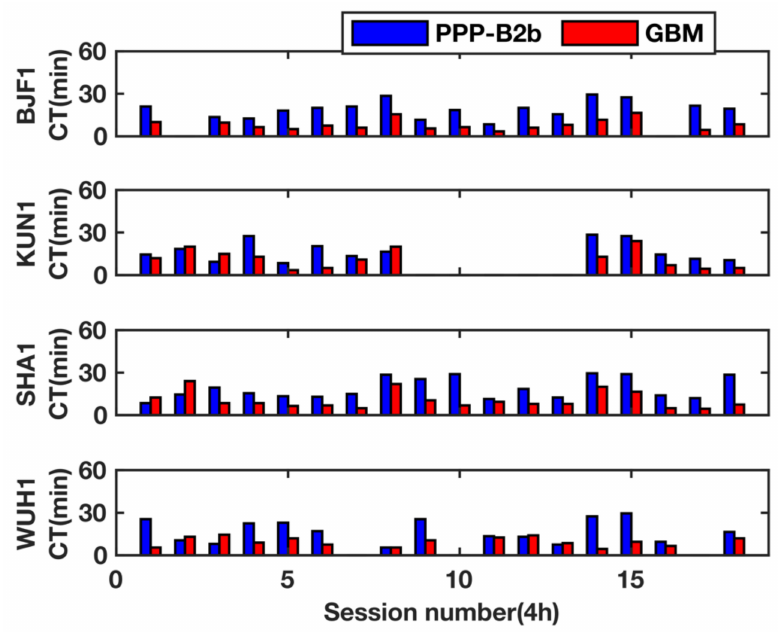
Figure 12. Convergence time of static PPP at different data